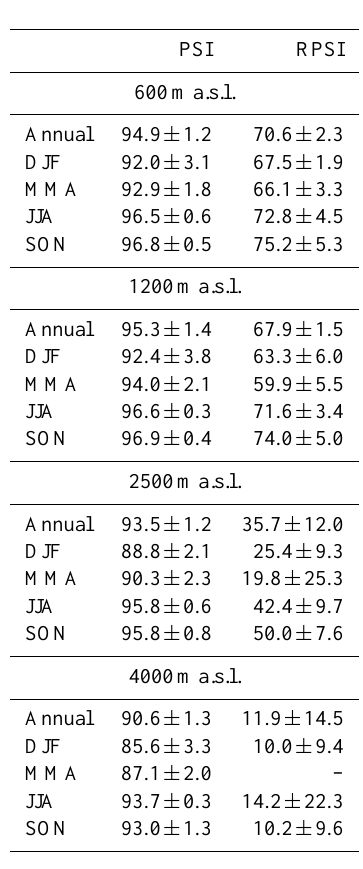
Table 1. Annual and seasonal average ( ± 1 standard deviation) of the Sorensen’s Quotient of Similarity ( Q/S ) for the PSI and the RPSI areas for the three sites belonging to the Linyola’s CAS for the set of 51 simulations for